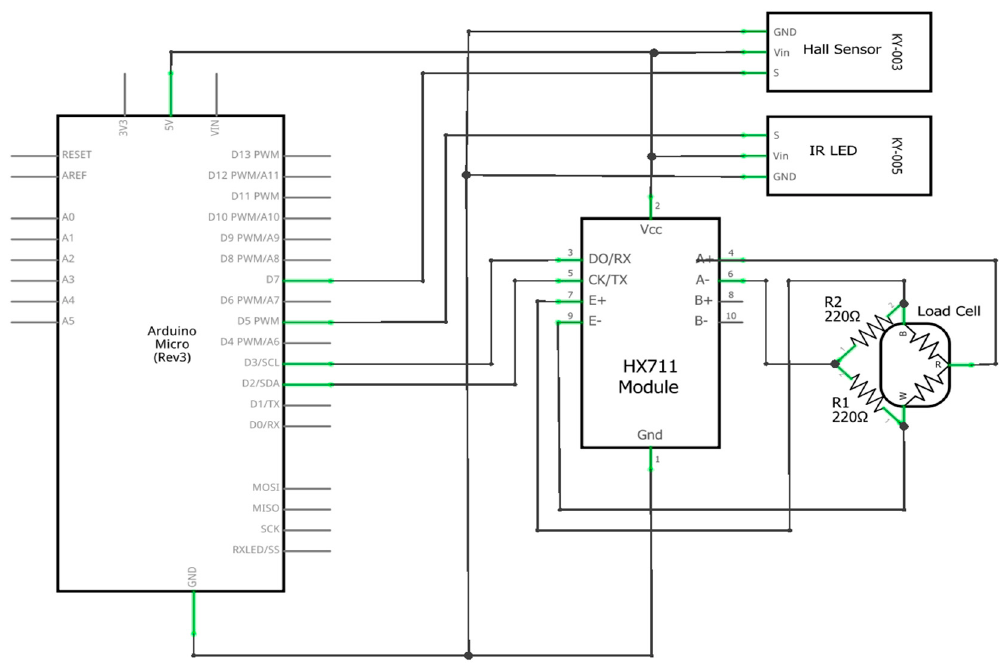
Figure 3. Pedal module wiring diagram.